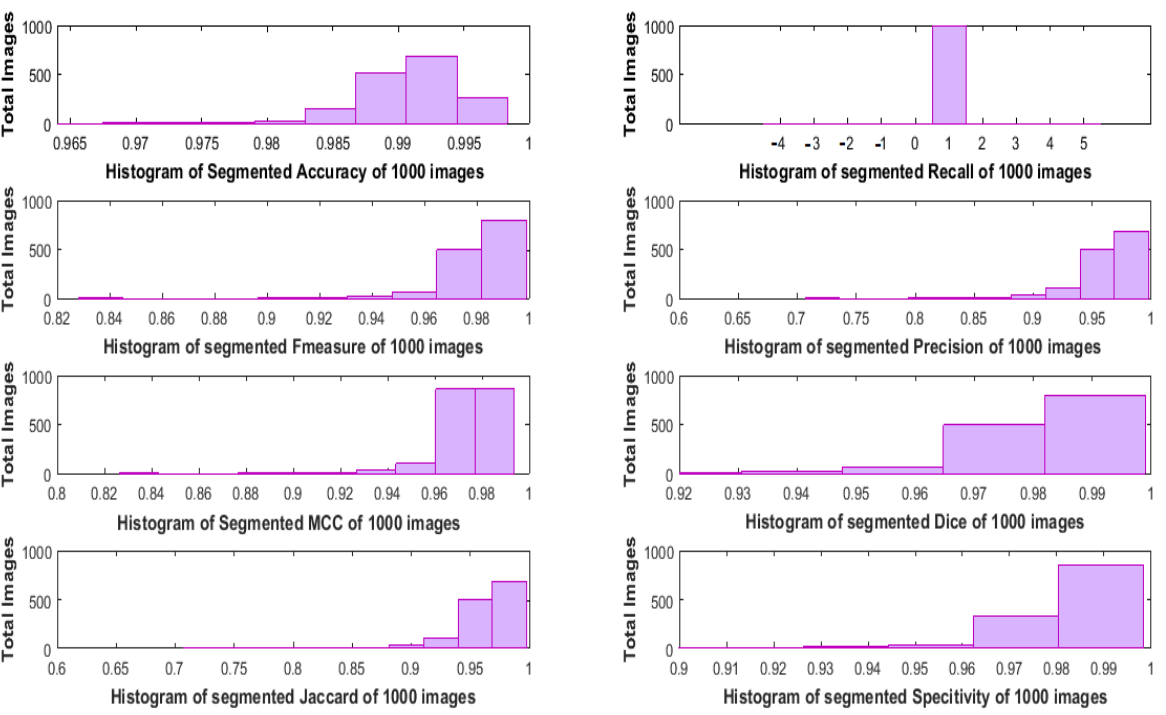
Figure 10. Numerous performance metrics are represented in histogram structures using overall 1000 partially-blurred images of the defocused-blur